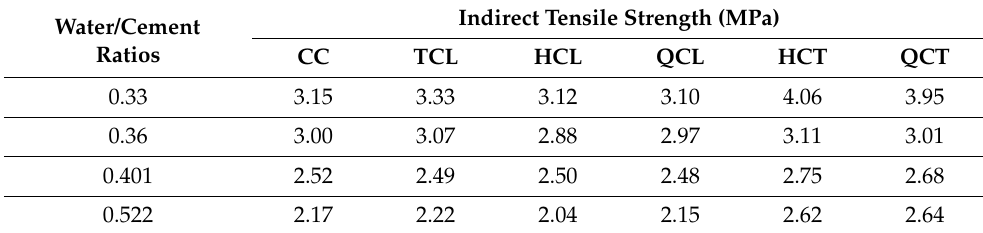
Table 7. Specimens’ experimental results of tensile